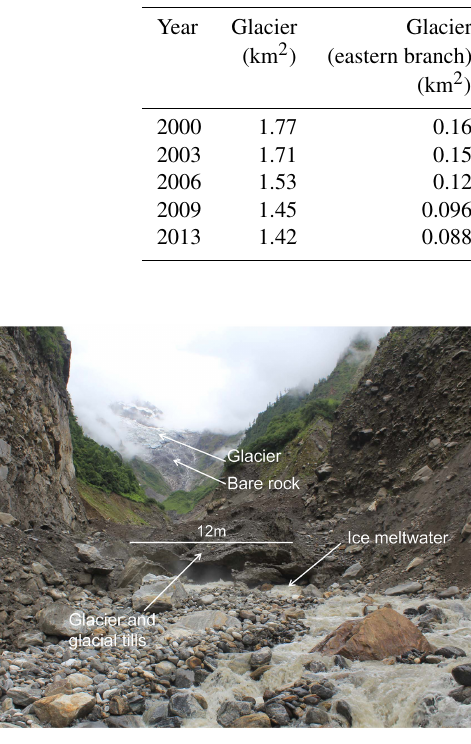
Figure 2. Overview of the valley from the channel (in